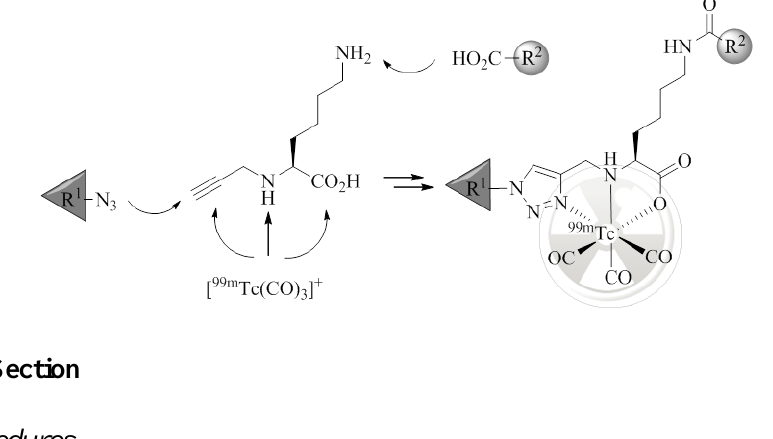
Figure 1. Assembly of multifunctional, 99m Tc-tricarbonyl-labeled peptide conjugates by amide bond formation, CuAAC, and (radio)metal complexation; residues R 1 and R 2 represent two different entities of biological function (e.g., derivatives of BBS and shepherdin) to be combined in the final